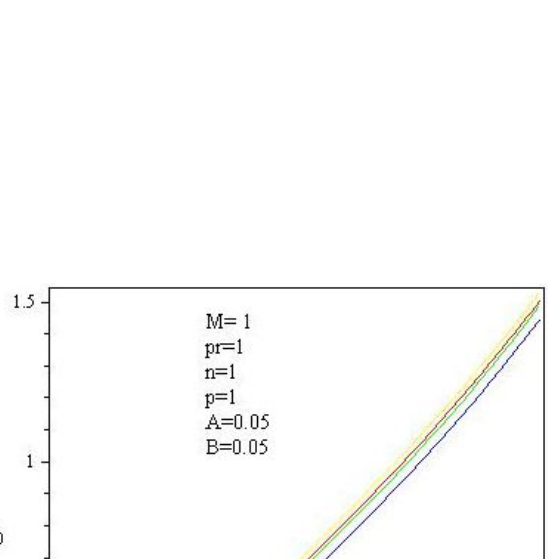
Fig. 2: Flow profile for different values of λ when β = σ = 0.5